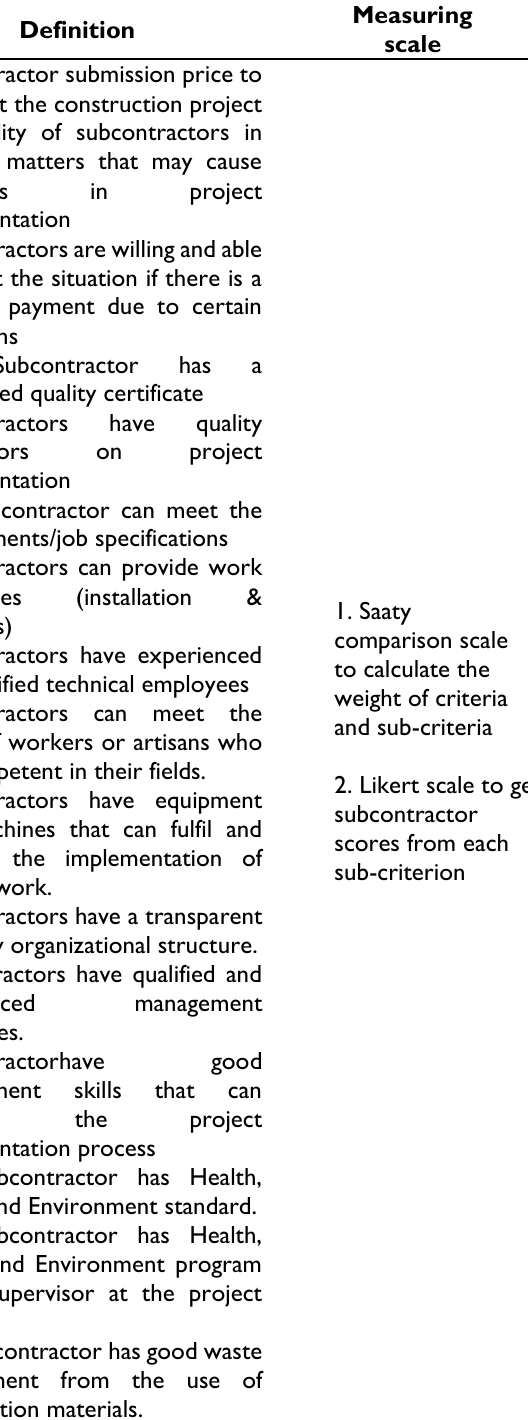
Table 1. Subcontractor selection criteria